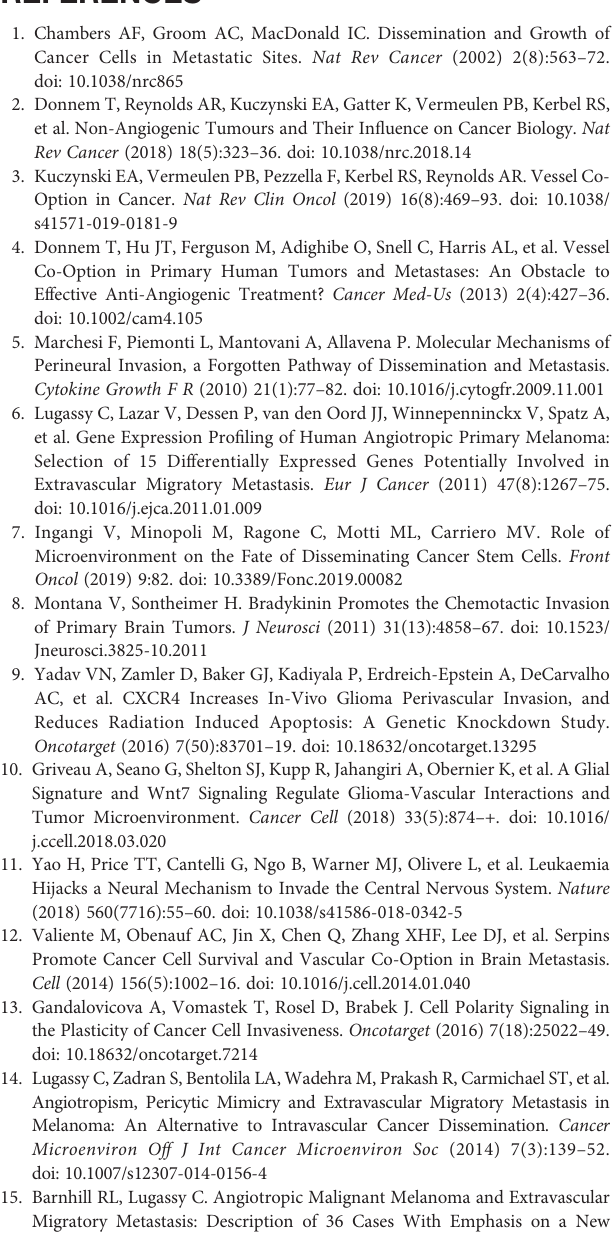
comparison of supernatant from melanoma cells as indicated; the lower panel shows the comparison of whole cell lysate from melanoma cells as indicated. Supplementary Figure 6 | Comparison of the expression and methylation levels of TFPI2 The dot plots show mRNA expression (A) and methylation levels (B) of TFPI2 in TCGA-UM and TCGA-CM datasets. The histogram shows the proportions of TFPI2 methylation in the above datasets (C) . Supplementary Figure 7 | Functional analysis of coexpressed genes of TFPI2 in melanoma Functional analysis of coexpressed genes of TFPI2 in TCGA-UM (A) and TCGA-CM (B) by KEGG pathway enrichment analysis. (C) The Venn diagram shows the overlapping genes among coexpressed genes of TFPI2 in TCGA-UM